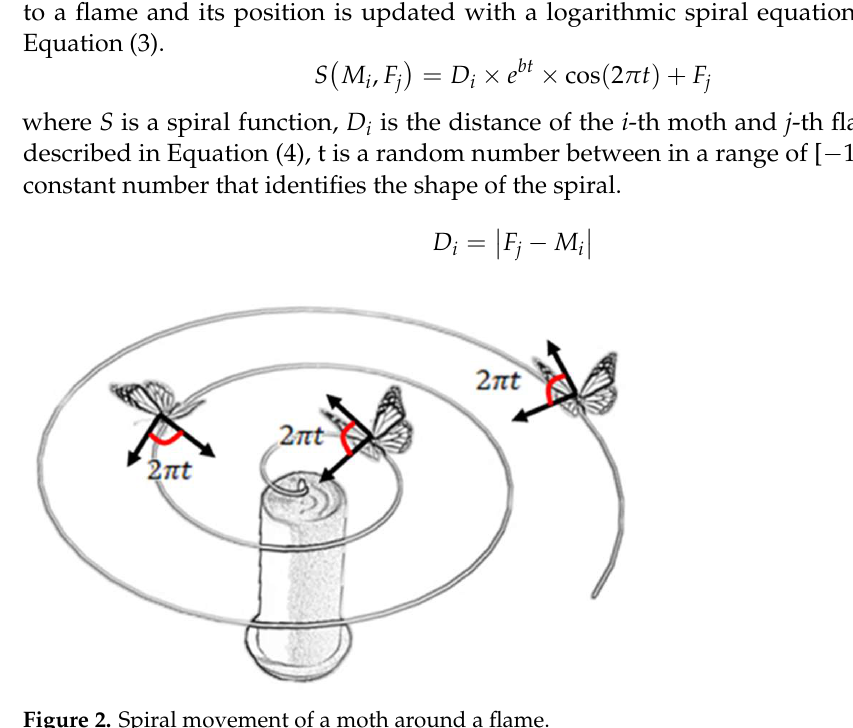
Figure 2. Spiral movement of a moth around a flame